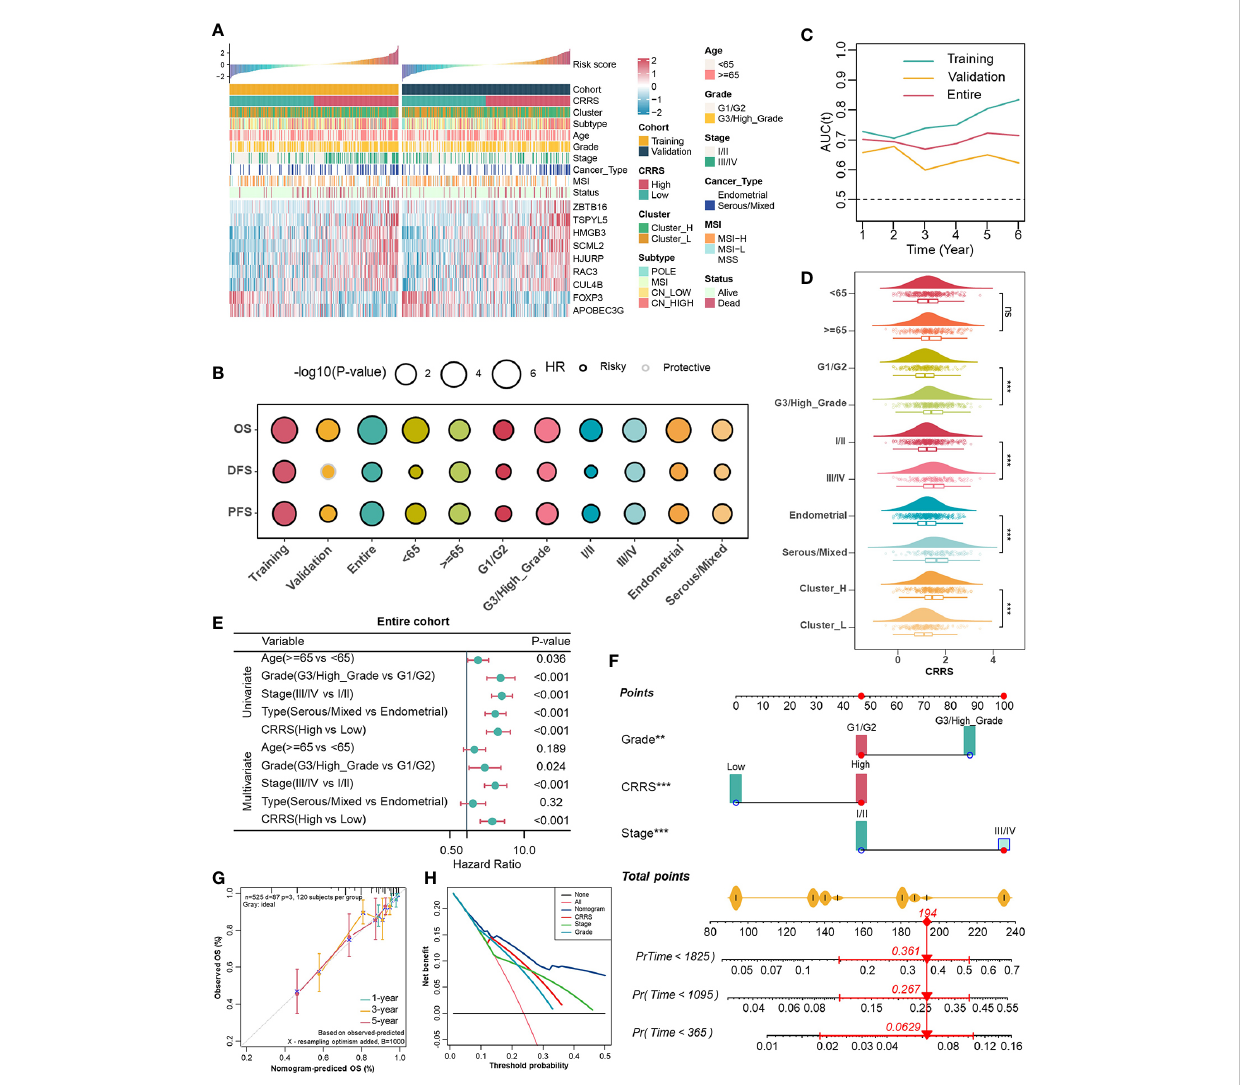
FIGURE 2 Associations between CRRS and clinicopathological features. (A) . Correlations between CRRS and 9 TME-associated CRs, clinicopathological features. (B) . Prognostic performance of the CRRS in different cohorts, age, grade, stage, and histological type. (C) . Time-dependent AUC value in the training, validation, and entire cohort. (D) . The distribution of CRRS among different clinicopathological features in the entire cohort. (E) . Univariate and multivariate Cox regression analyses evaluating independently predictive ability of CRRS and other clinicopathological features for OS in the entire cohort. (F) . Multivariate Cox regression analysis nomogram for predicting EC patients ’ 1-/3-/5-years overall survival. (G) . Calibration curve for predicting OS at 1, 3, and 5 years. (H) . Decision curves for 5-year-OS in the entire